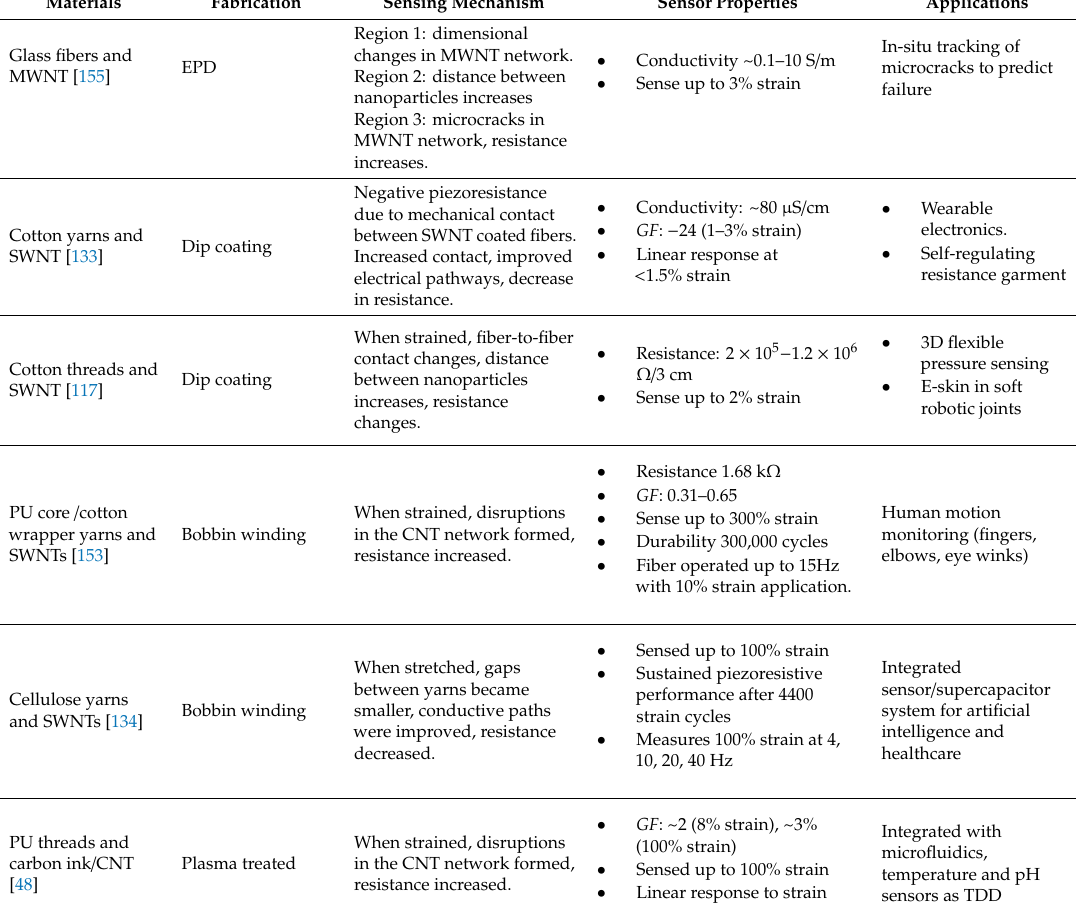
Table 2. Fiber-based strain sensors coated with carbon